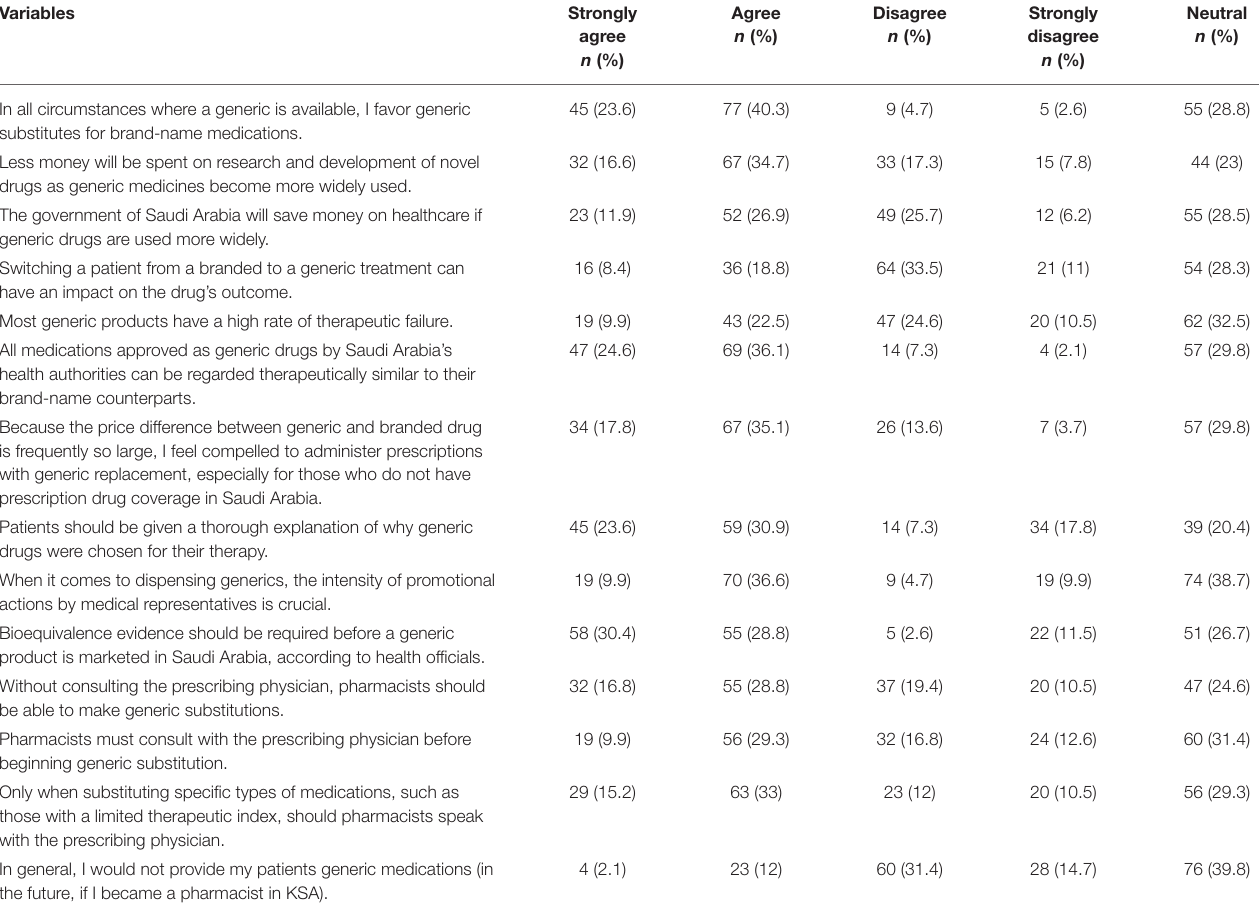
TABLE 3 | Attitudes on generic medicines utilization ( n = 193). Variables Strongly